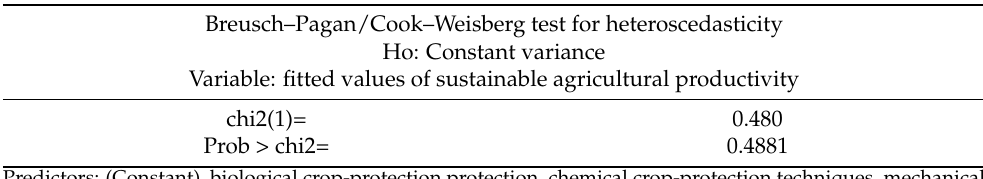
Table 9. Model Summary.